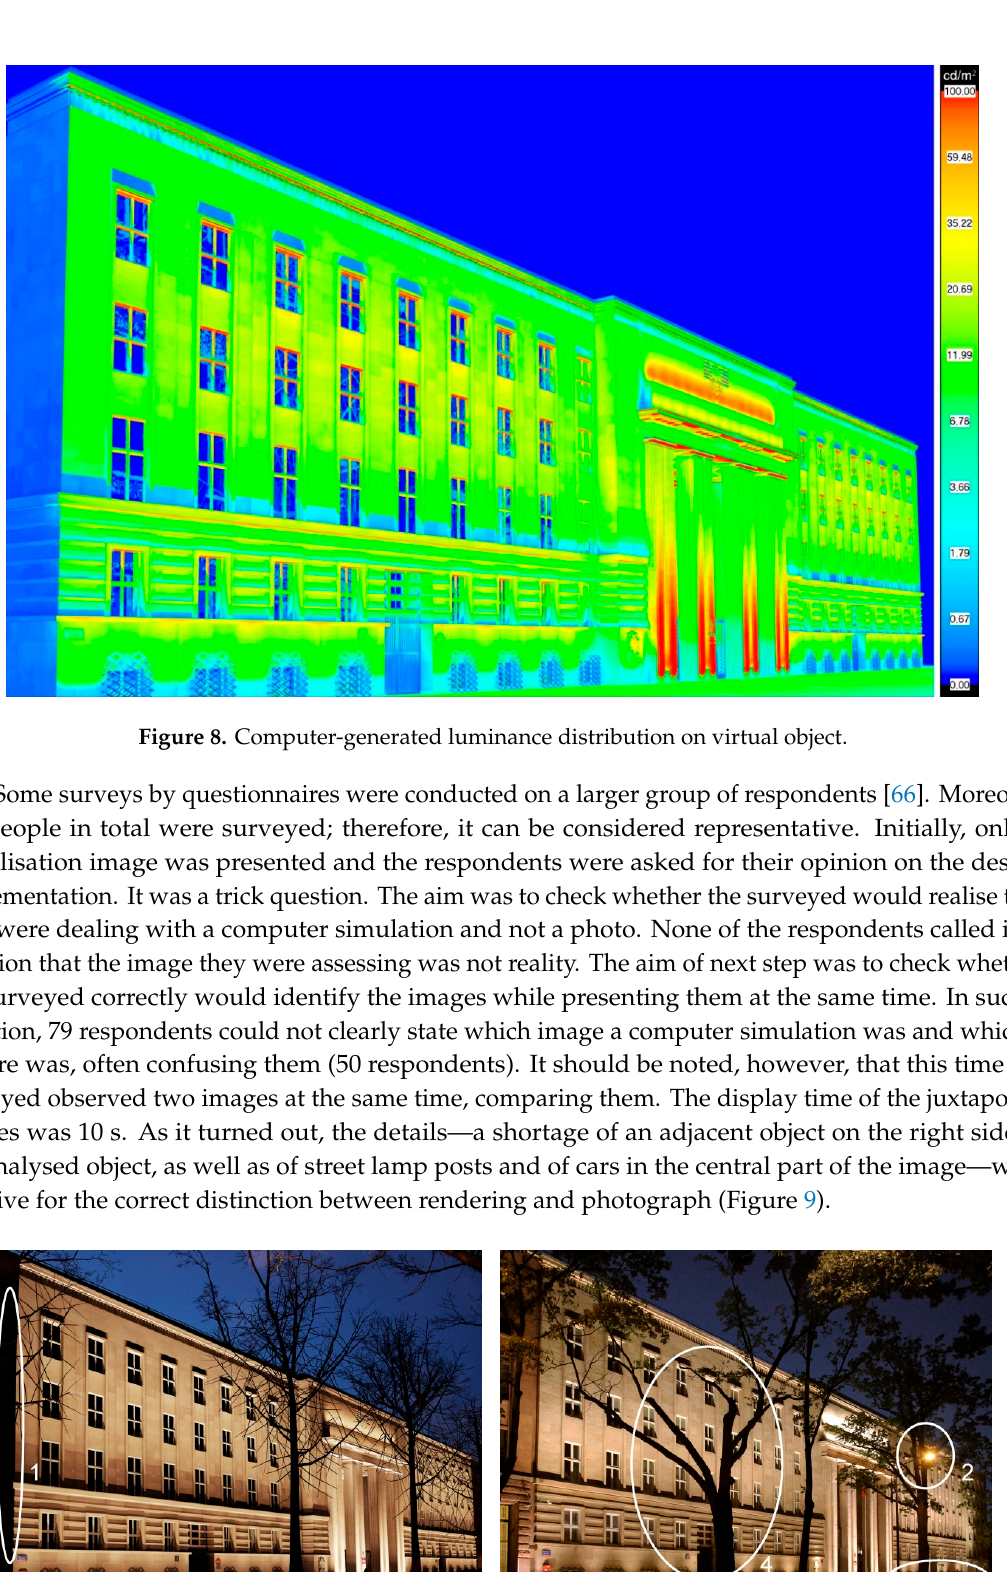
( b ) Figure 7. Comparison of luminance measurements of VR display for: ( a ) rendering and ( b ) post-implementation photograph. The luminance measurements of the visualisation and post-implementation picture displayed on the screen of the glasses were also compared with those calculated in the design. Most computer software products allow us to perform the rendering in the form of false colour scale. Only on the basis of such images, is it possible to objectively evaluate the design, since this image is independent of exposure parameters. Unfortunately, this type of analysis may be burdened with some errors.